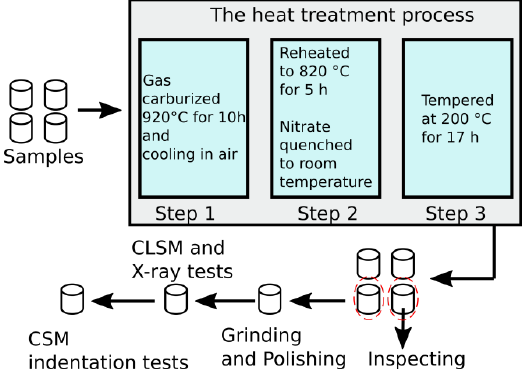
Figure 1. Methodology of the test process.